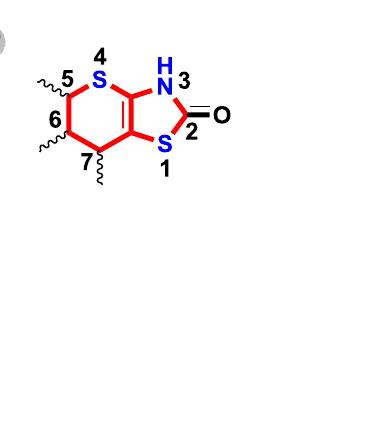
Table 1. Anticancer activity data of compound 3 at a concentration of 10 μM.